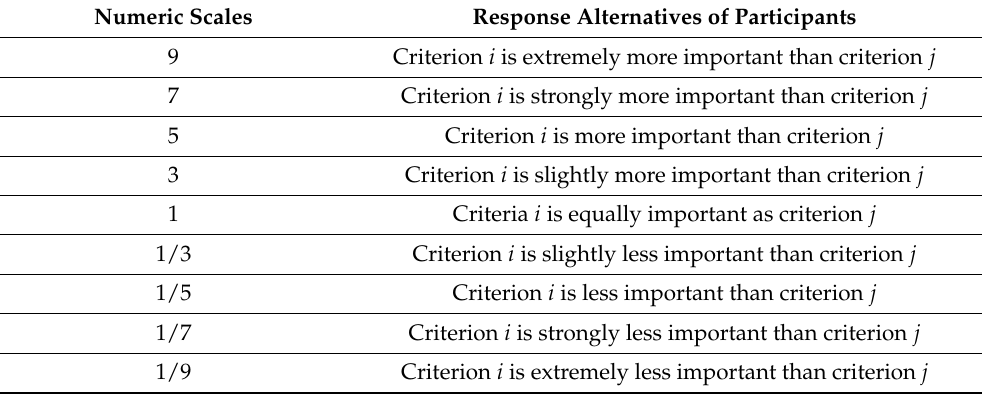
Table 2. Numeric scale for the pairwise